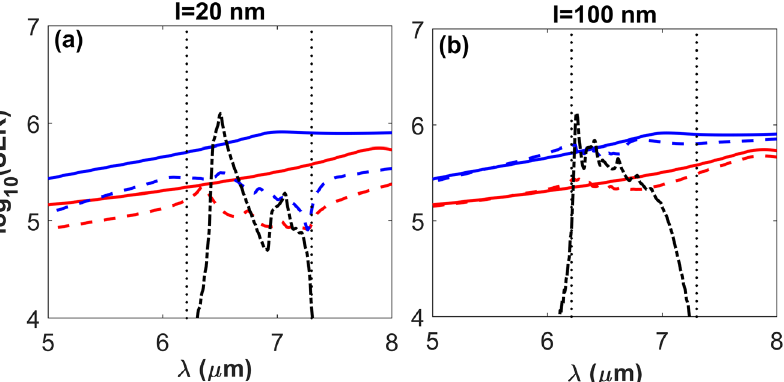
Figure 4: SERs of quantum emitter located 10 nm above A2DM/sub structure (solid curves) and A2DM/hBN/sub structure (dashed curves) with 20- and 100-nm-thick hBN layers for n (cid:1) 3 × 10 13 cm − 2 (blue curves) and n (cid:1) 10 14 cm − 2 (red curves). Dash-dotted curves show SERs of emitter above similar hBN/sub structures; dotted vertical lines mark the boundaries of the type-II RS band of